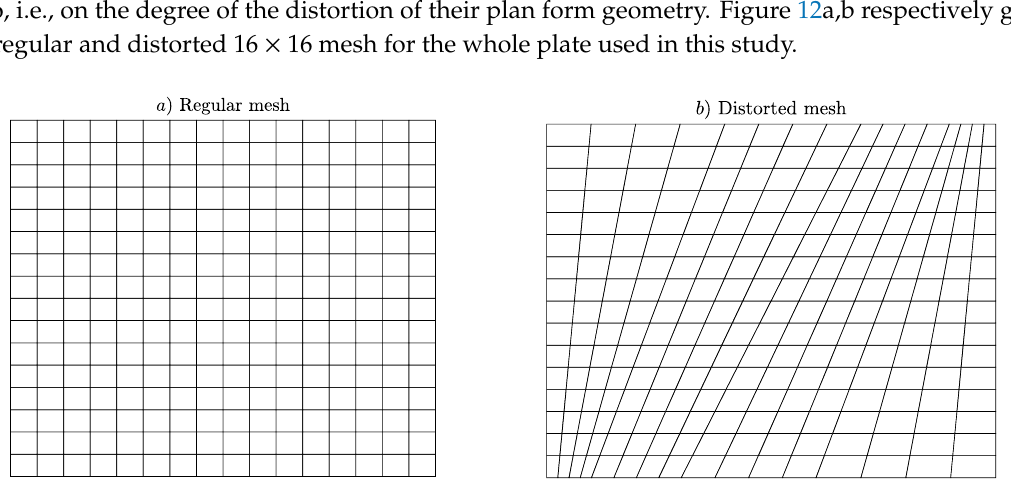
Figure 12. Regular ( a ) and distorted ( b ) 16 × 16 mesh.